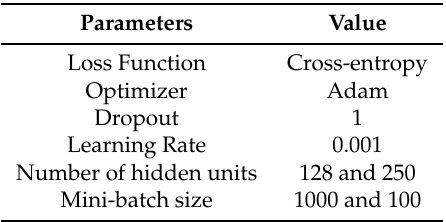
Table 3. Model parameters of conventional and proposed